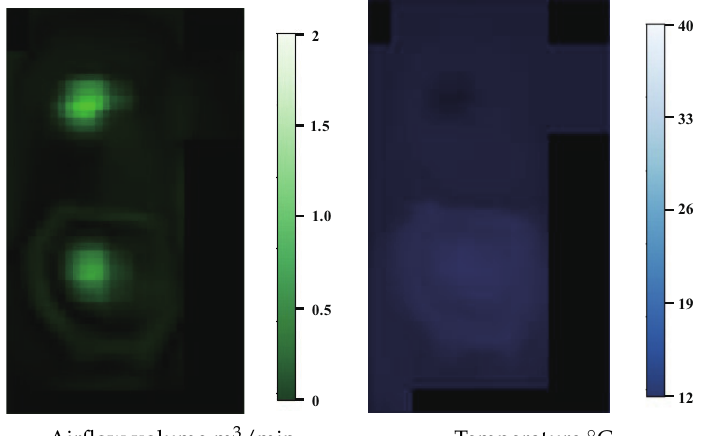
Figure 1. Examples of input